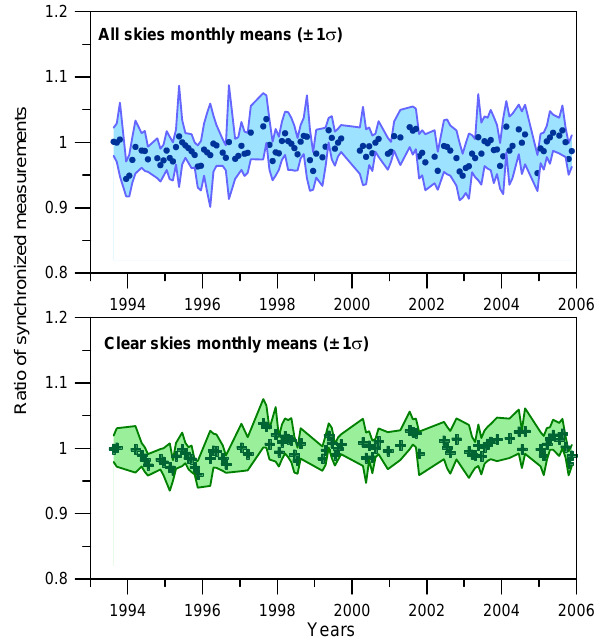
Time series of monthly mean ratios (Brewer #086 over Brewer #005) formed by irradiance integrals (315–320nm) recorded within 1min by the two Brewer spectroradiometers at Thessaloniki, under all-sky (upper panel) and clear-sky (lower panel) conditions. The shaded envelope corresponds to the standard deviation ( ± 1 σ) of the